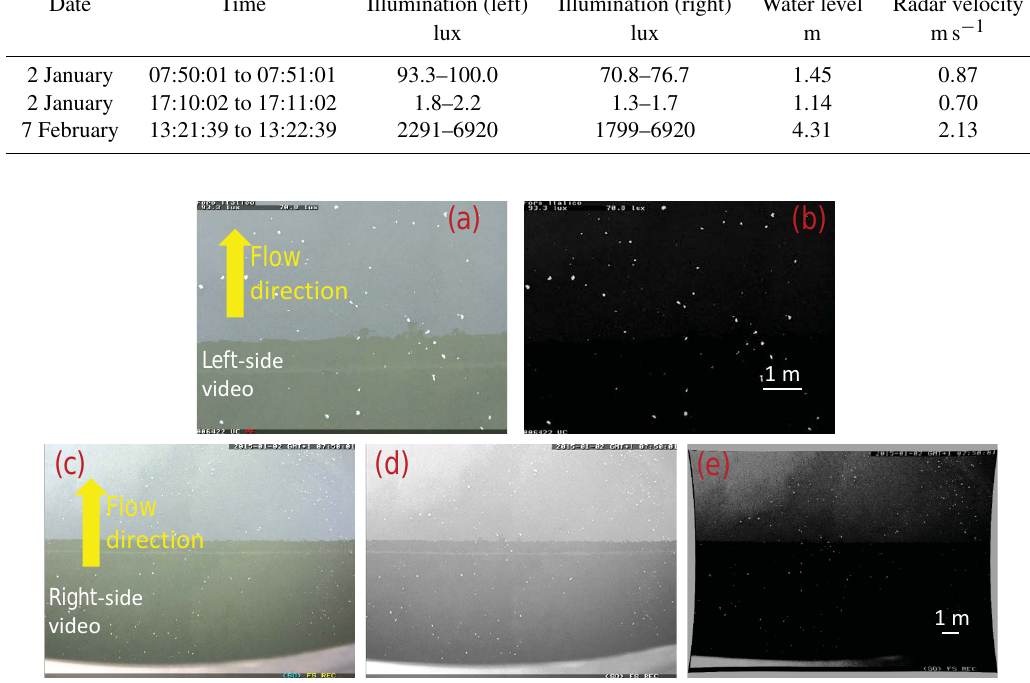
Figure 4. Image processing for left-side ( a and b ) and right-side ( c , d , and e ) videos captured on 2 January, at 07:50LT. Left-side videos are (a) isolated and (b) filtered and midtone-corrected. Right-side videos are (c) isolated, (d) filtered, and (e) fish-eye undistorted and midtone-